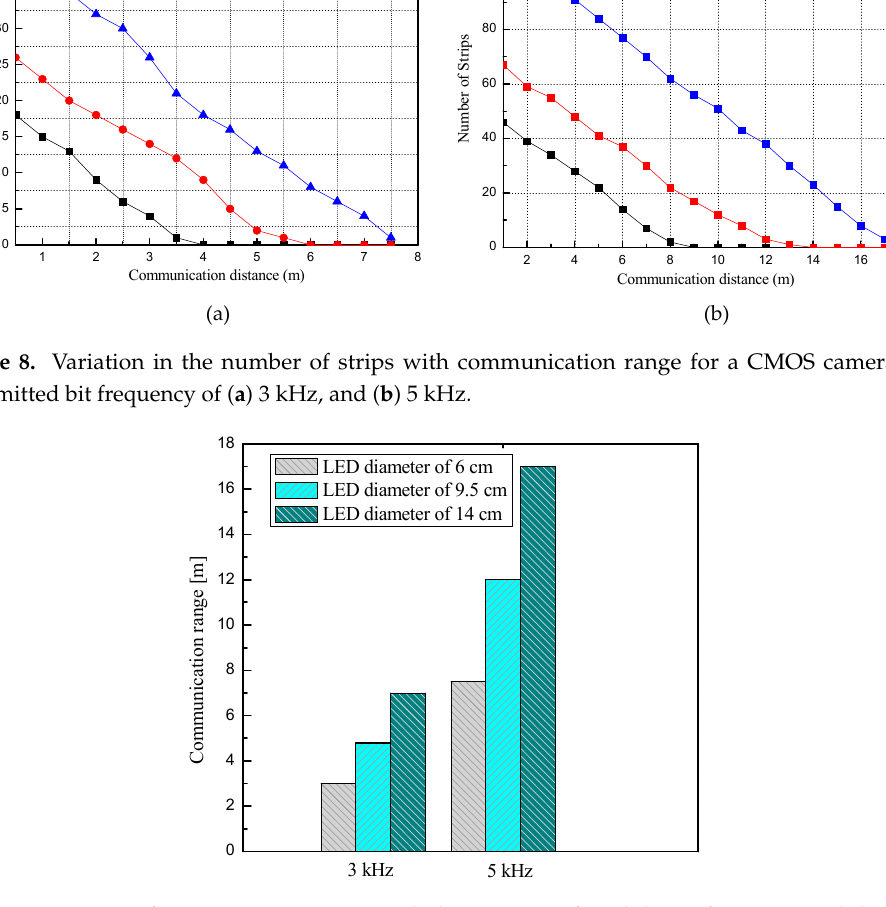
Figure 9. Variation of communication range with the variation of modulation frequency and change of LED size.